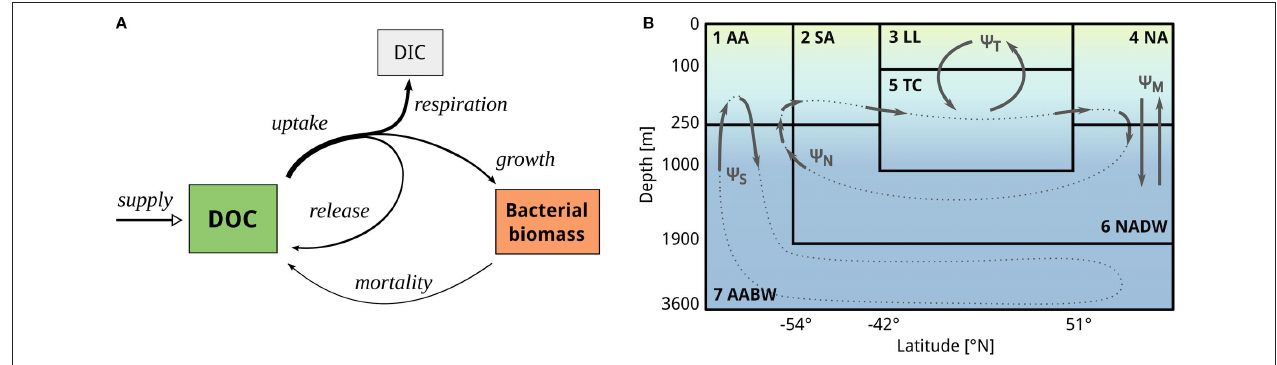
FIGURE 1 | Scheme of the two model compartments. (A) The simplified DOC-microbe-interaction model, based on Mentges et al. (2019), predicts the concentration of DOC, the carbon concentration of microbial biomass, and the concentration of inorganic carbon (not shown in results). Microbes take up DOC, partially convert it to inorganic carbon, partially release it back to the DOC pool, and fix the remaining carbon into microbial biomass. DOC is supplied at a fixed rate from primary production. This simplified DOC-microbe-interaction model is coupled to (B) a seven box model, adapted from Toggweiler (1999). The box model comprises four surface boxes (AA, Antarctic surface water; SA, Sub-Antarctic surface water; LL, Low-latitude surface water, NA, North Atlantic surface water) and three deep boxes (TC, Thermocline; NADW, North Atlantic deep water; AABW, Antarctic Bottom Water). DOC and microbial biomass are transported from one box to another along four circulation pathways based on the overturning circulation: deep convective mixing in the North Atlantic 9 M , the ventilation of the thermocline 9 T , and the thermohaline deep circulation in the northern and southern hemispheres 9 N , 9 S (dotted lines), approximating the formation rates of NADW and AABW, respectively. The rate of DOC supply from primary production is specific to each box. Note that the axes are non-linearly scaled for illustration